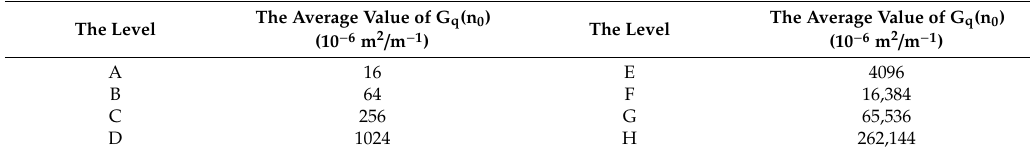
Table 4. The coefficient of road roughness. Table 4. The coe ffi cient of road roughness.